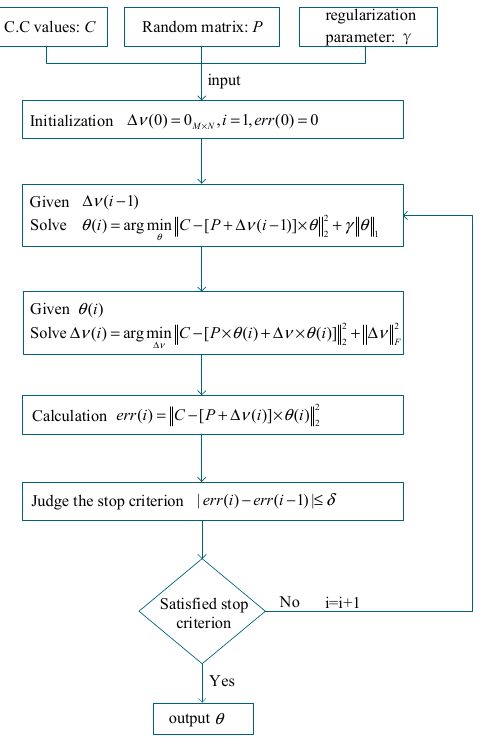
Figure 2. Coordinate descent method for solving STLS.